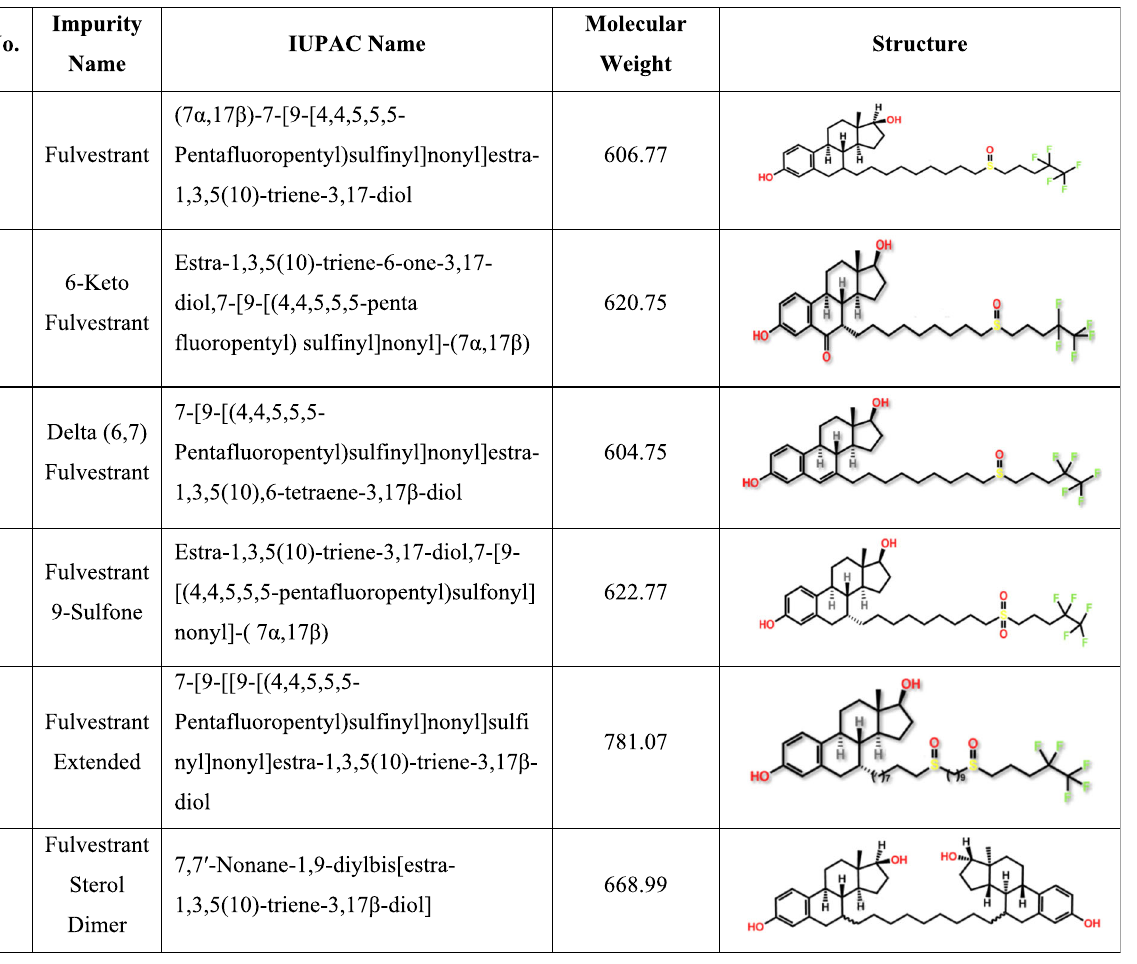
Fig. 1 Fulvestrant and its impurity names and chemical